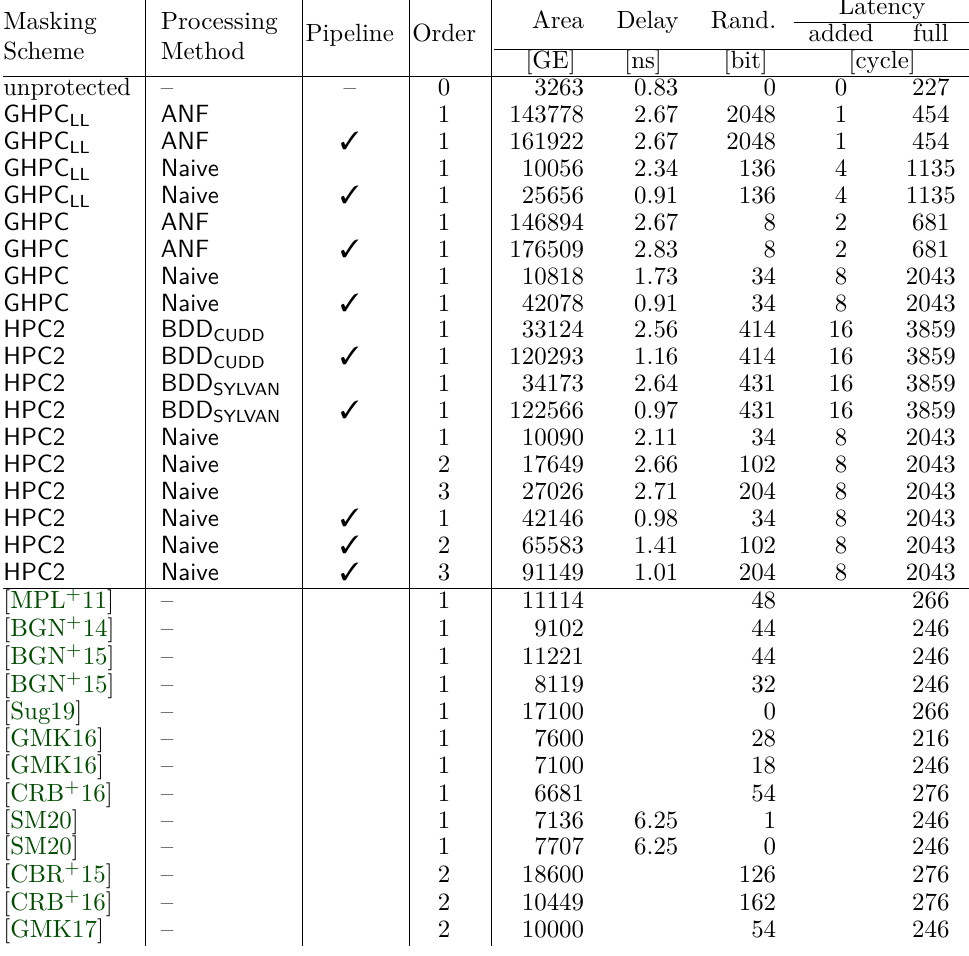
Table 8: Synthesis results, AES byte-serial encryption function.